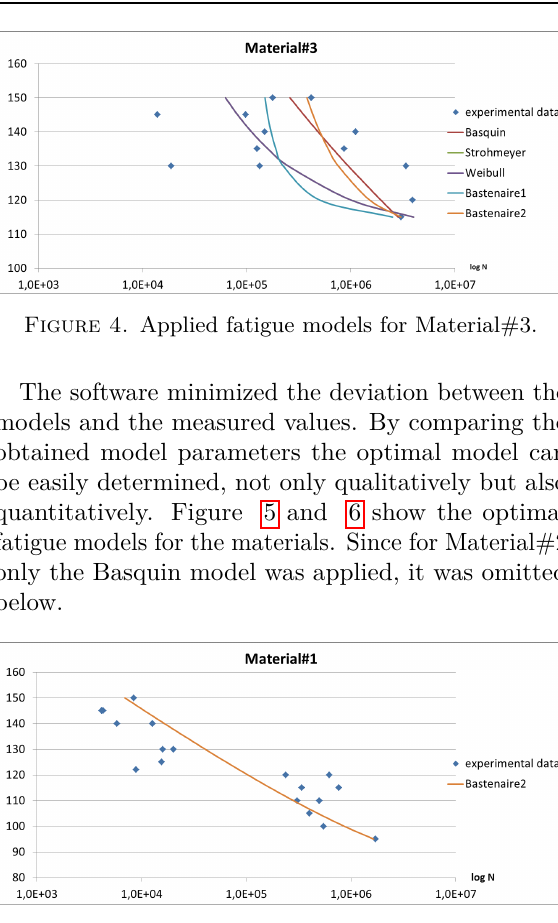
Figure 5. Optimal fatigue model for Material#1.